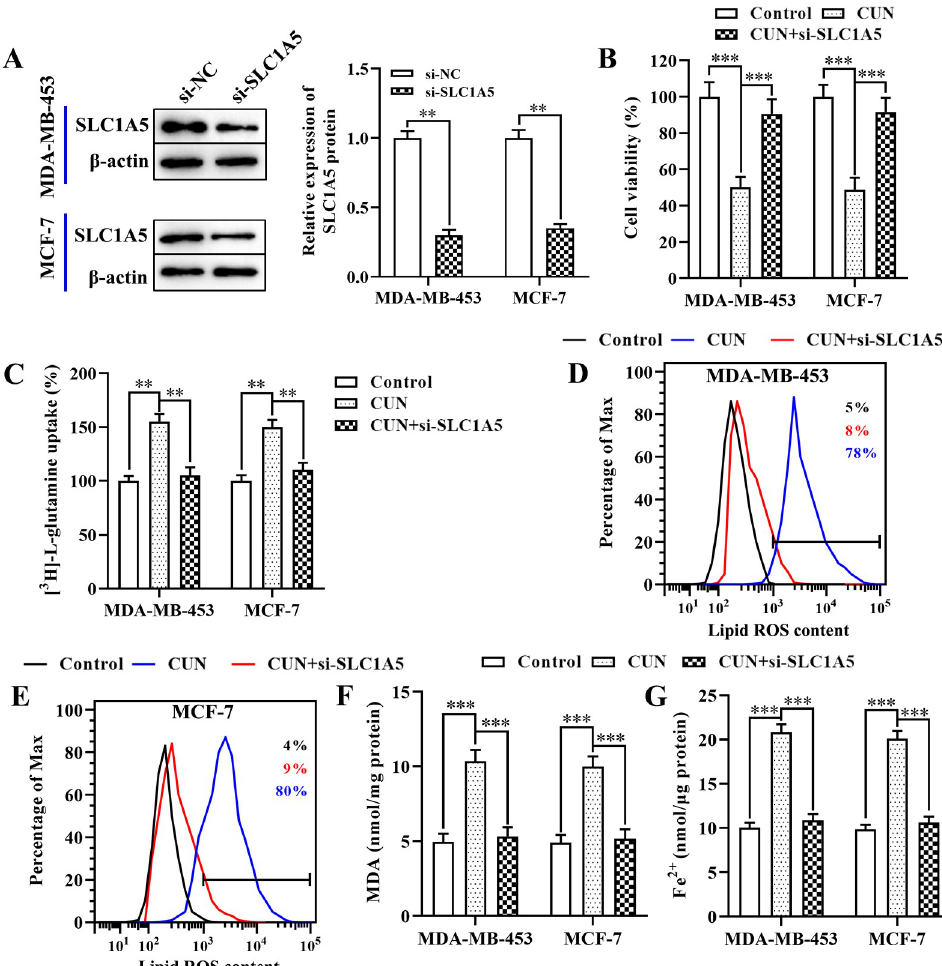
Fig 4. Treatment with CUN facilitates ferroptosis via upregulation of SLC1A5 expression in BC. A: Western blot analysis was performed to examine the protein levels of SLC1A5 in both BC cell lines following transfection with si- SLC1A5 or si-NC; B: The CCK-8 assay was used to examine the effects of SLC1A5 knockdown on cell viability in both BC cell lines; C: The [ 3 H]- L -glutamine uptake was determined using a liquid scintillation counter; D and E: Flow cytometry was employed using C11-BODIPY to detect the levels of lipid ROS in BC cell lines treated with curcumin or erastin; F: The MDA accumulation in both BC cells was examined by a lipid peroxidation assay kit; G: The intracellular Fe 2+ levels in both BC cell lines were measured by an iron assay kit. Each data point is expressed as mean ± SEM of 3–5 independent tests. �� P < 0.01. CUN, curcumin; SLC1A5, solute carrier family 1 member 5; BC, breast cancer; si- SLC1A5, SLC1A5 small interfering RNA; si-NC, NC-small interfering RNA; CCK-8, cell counting kit-8; ROS, reactive oxygen species; MDA, malondialdehyde; SEM, standard error of the